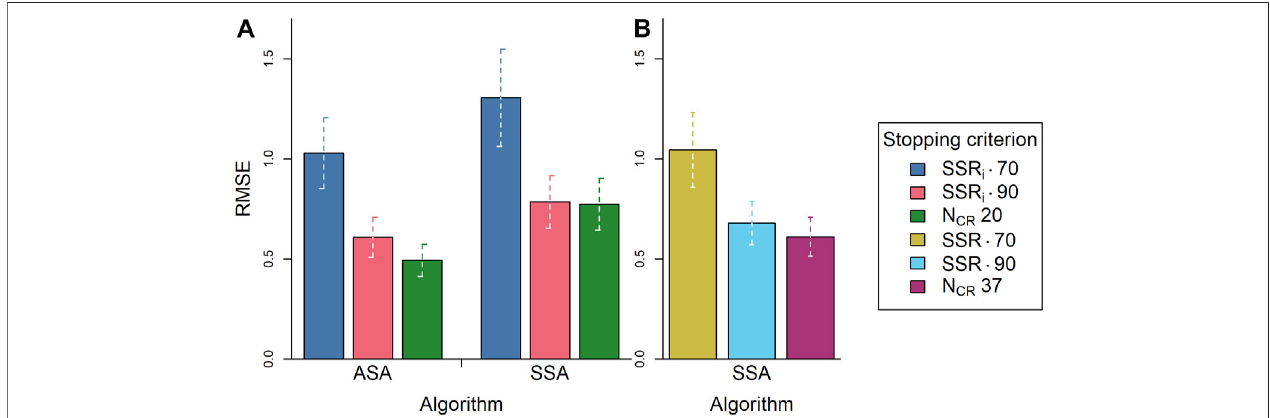
FIGURE 6 | The root mean squared error (RMSE; n = 20) averaged over simulation repetitions ( n = 1,000) per algorithm (ASA, SSA) and per stopping criterion [colors; (A) SSR i 0.70, SSR i 0.90, N CR 20; (B) SSR 0.70, SSR 0.90, N CR 37] with 95% con fi dence intervals ( n = 1,000). Note: Panel B contains only SSA data. ASA = adaptive selection algorithm; SSA = semi-random selection algorithm; SSR i = estimated reliability; N CR = number of comparisons per representation; SSR = rank-order reliability.